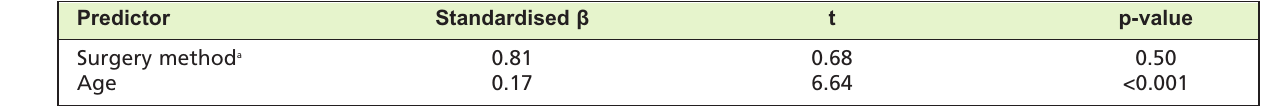
Regression analysis for months to union Table II: